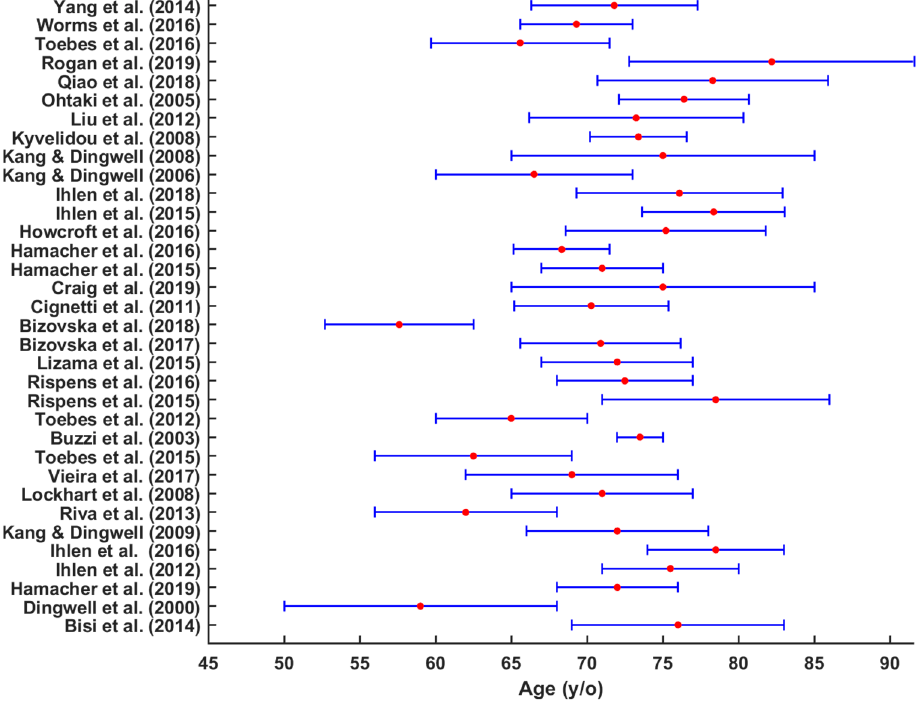
Figure 2. Mean and SD age (years) of older participants in the studies. Table 1. Equal gender/ Sex ratio, sample size, participant’s gender (Female, Male or not mentioned (nm)), overground (OG) or on the Treadmill (TM) or Both (Both) cohorts in studies in corporation F-NF or YO comparisons.